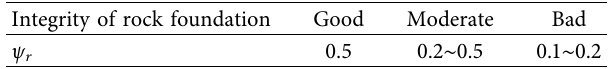
Table 2: Recommended values of the reduction factor ψ